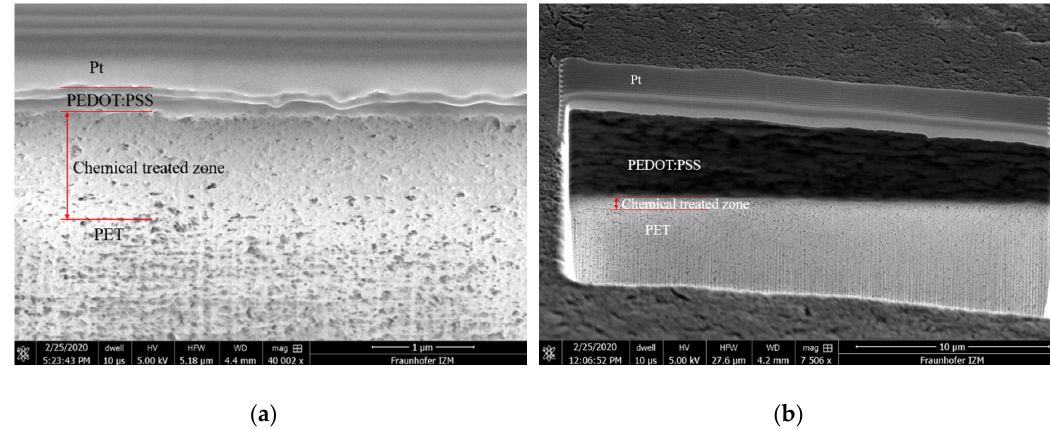
Figure 5. SEM cross section images of ( a ) single-layer printed PEDOT:PSS and ( b ) of a 10-layer printed PEDOT:PSS.